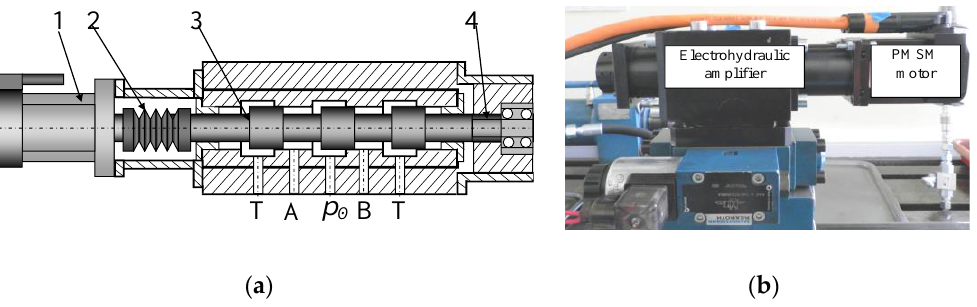
Figure 2. Proportional valve with synchronous motor (A, B —valve’s ports, p 0 — power supply, T — tank): ( a ) drawing, ( b )